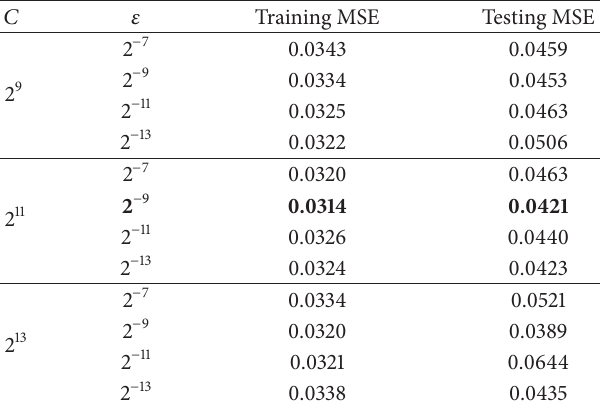
Table 5: Model selection results of the s-stICA-SVR model.